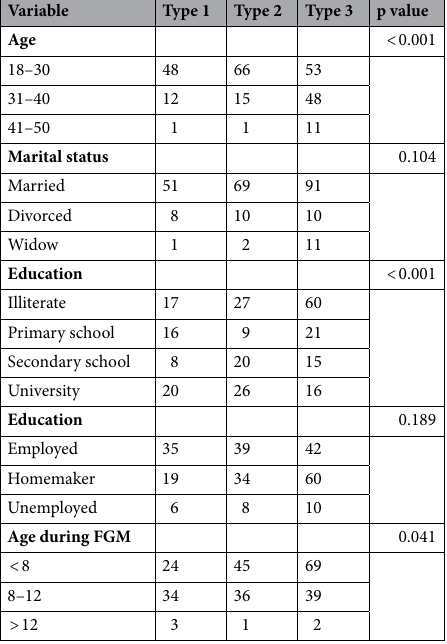
Table 1. Correlation of the socio-demographic characteristics with different types of FGM. Type 1, Sunna: clitoridectomy, Type 2: excision, Type 3, pharaonic: infibulation. FGM: female genital mutilation. Statistical analysis was performed using Pearson’s chi-square ( χ 2 )